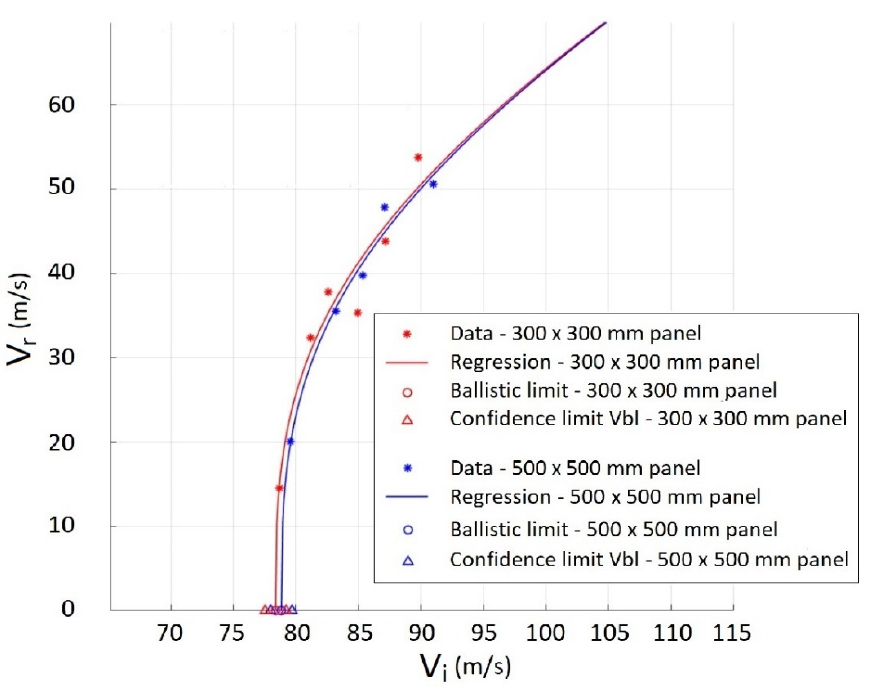
Figure 7. Comparison of R&I laws for the two different plate sizes.